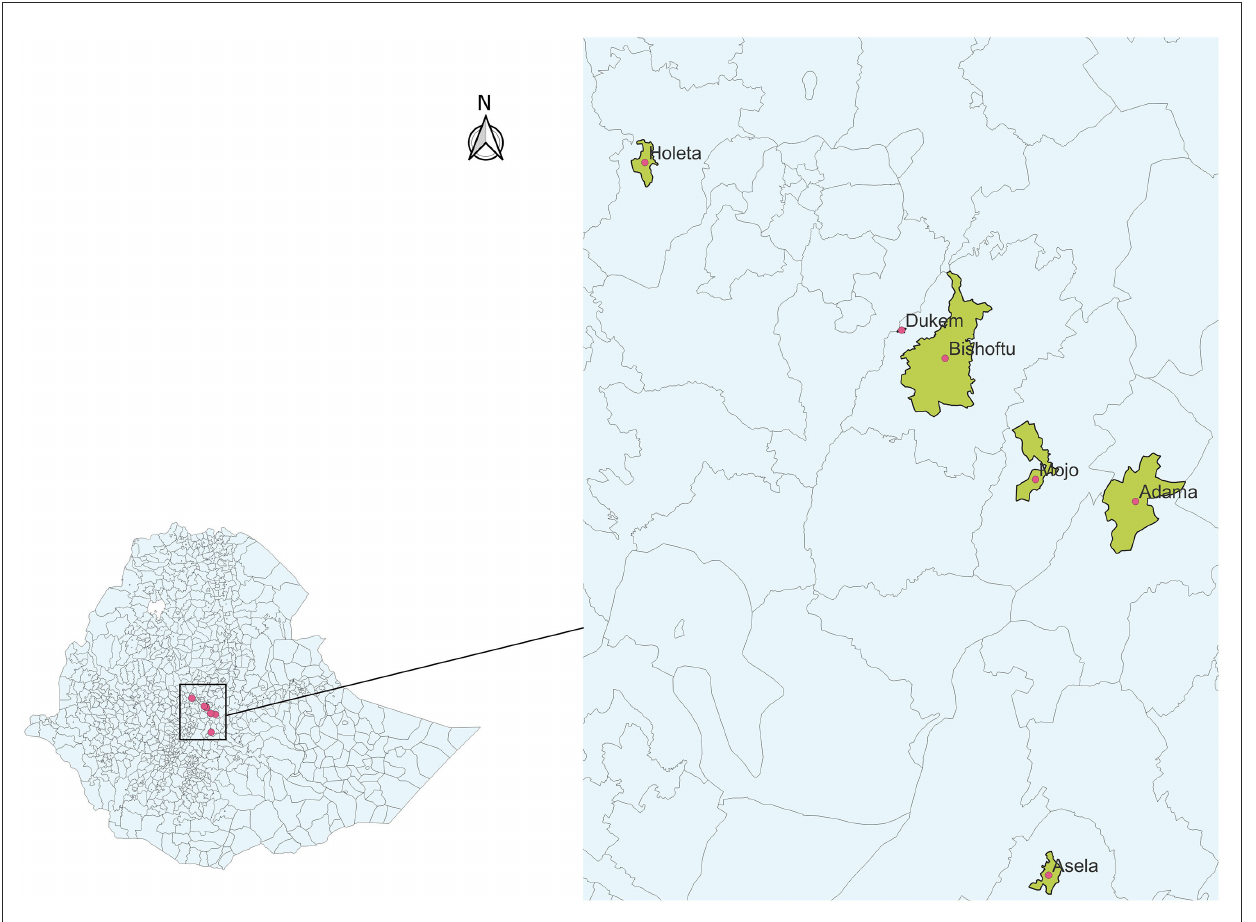
FIGURE1 Map of Ethiopia showing the relative location of the towns of the study farms.